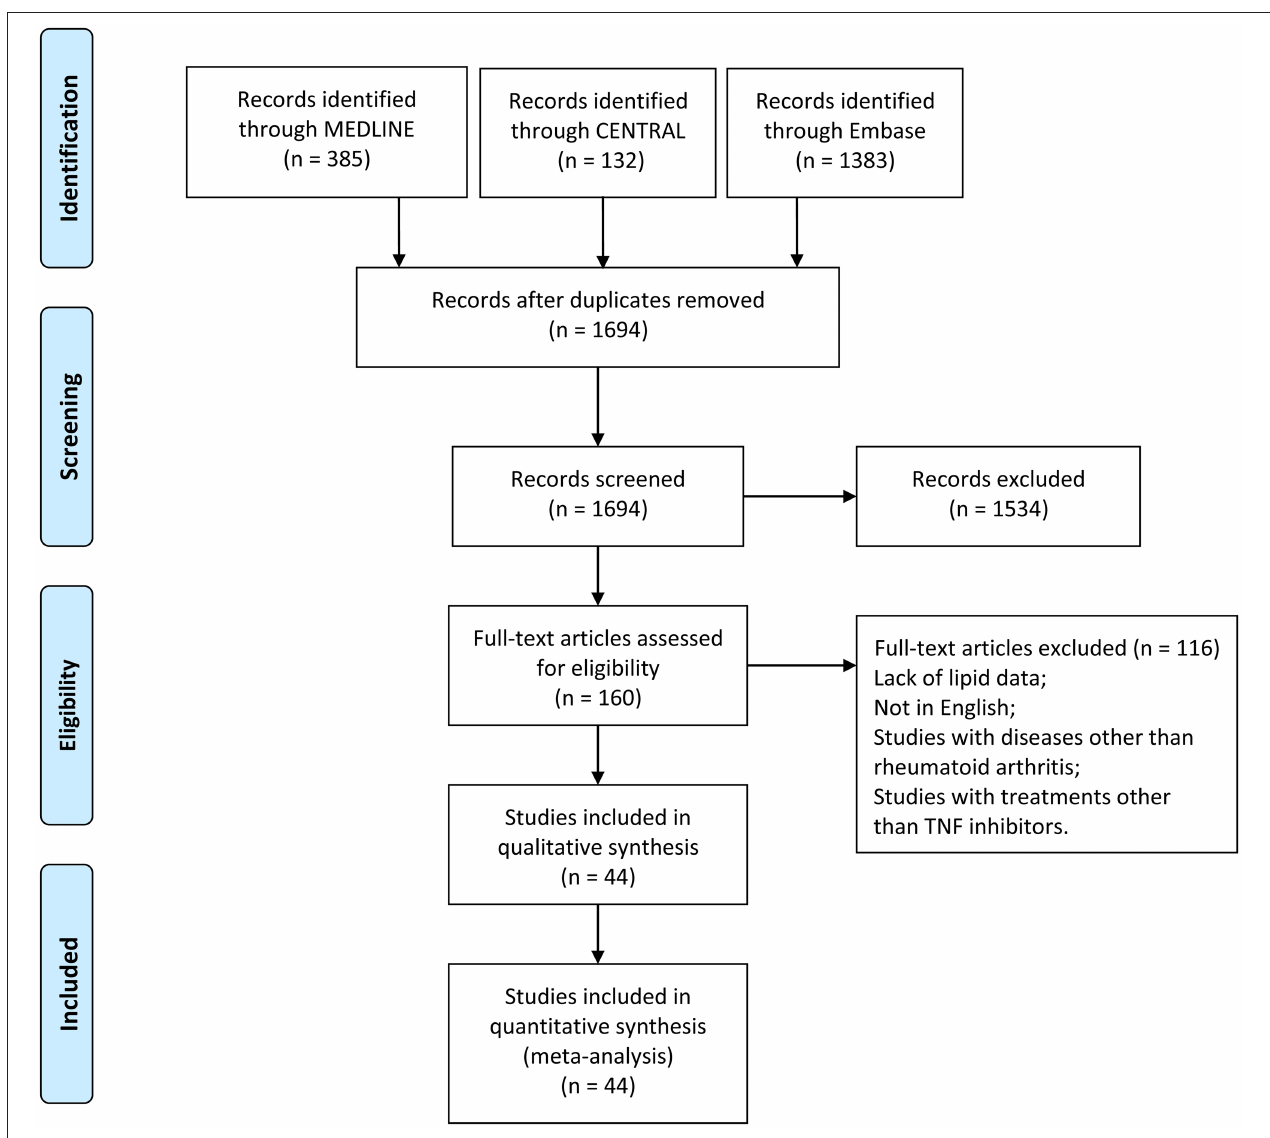
FIGURE 1 | Flow diagram of studies identified, included, and excluded. CENTRAL, Cochrane Central Register of Controlled Trials.